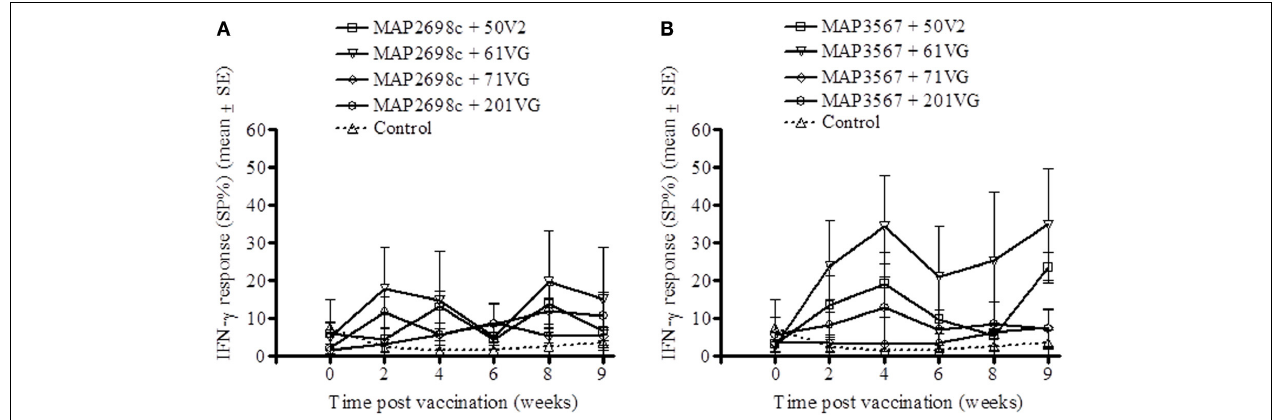
FIGURE 1 | MAP 316v specific IFN- γ responses from recombinant antigen vaccinated sheep. (A) Responses in sheep vaccinated with MAP2698c vaccine; (B) Responses in sheep vaccinated with MAP3567 vaccine. Data are mean ± SE .